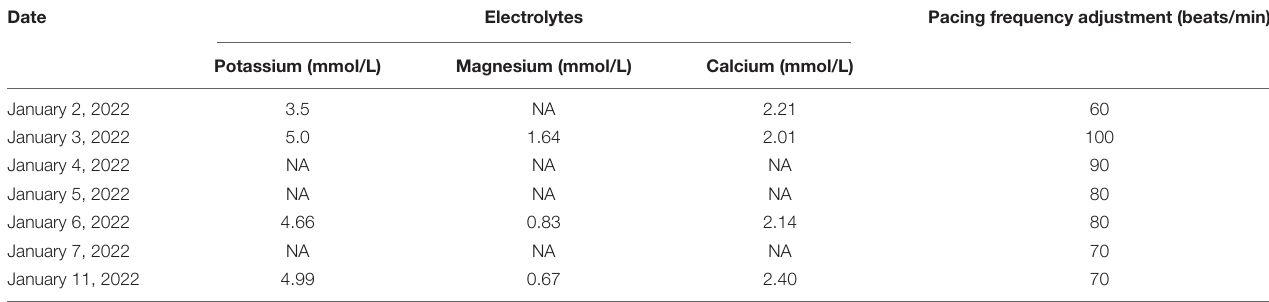
TABLE 1 | Serum electrolyte and pacing frequency adjustment in hospital.